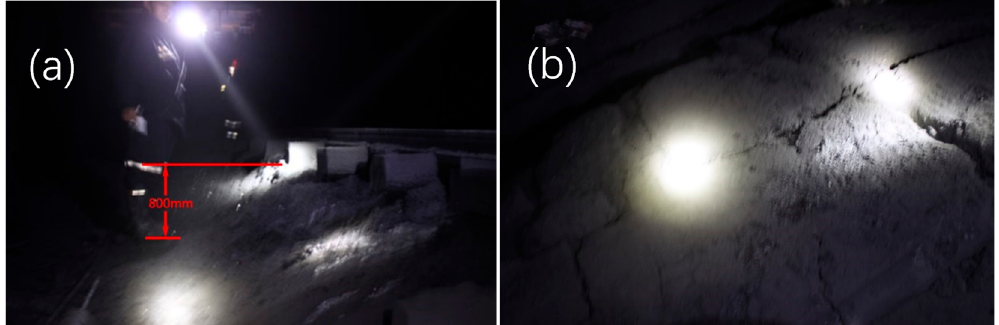
Figure 15. Floor deformation and failure of the working face 8407. ( a ) Floor heave; ( b ) floor expansion and cracking.